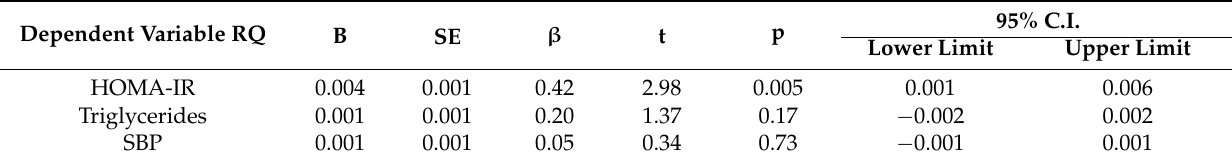
Table 4. Multivariate linear regression analysis—factors associated with respiratory